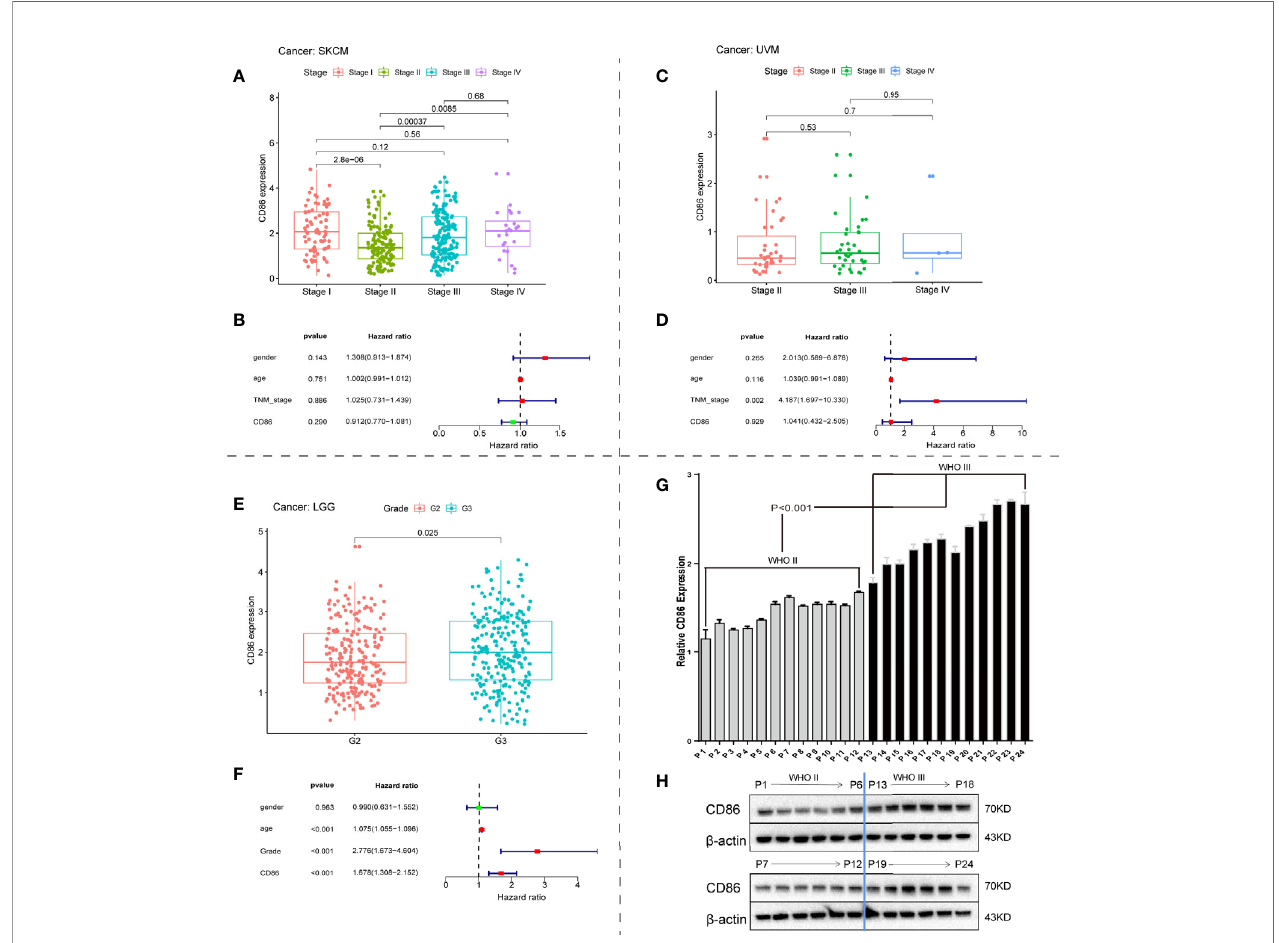
FIGURE 4 | Correlations between CD86 expression and tumor progression. CD86 expression in different stages of SKCM (A) and UVM (C) . Multivariate regression analysis of CD86 expression, age, gender, and tumor stage for OS in SKCM (B) and UVM (D) . (E) CD86 expression between different grades of LGG. (F) Multivariate regression analysis of CD86 expression, age, gender, and tumor grade for OS in LGG. (G) CD86 mRNA expression evaluated by qRT-PCR in different grades of LGG. (H) CD86 protein expression evaluated by WB in different grades of